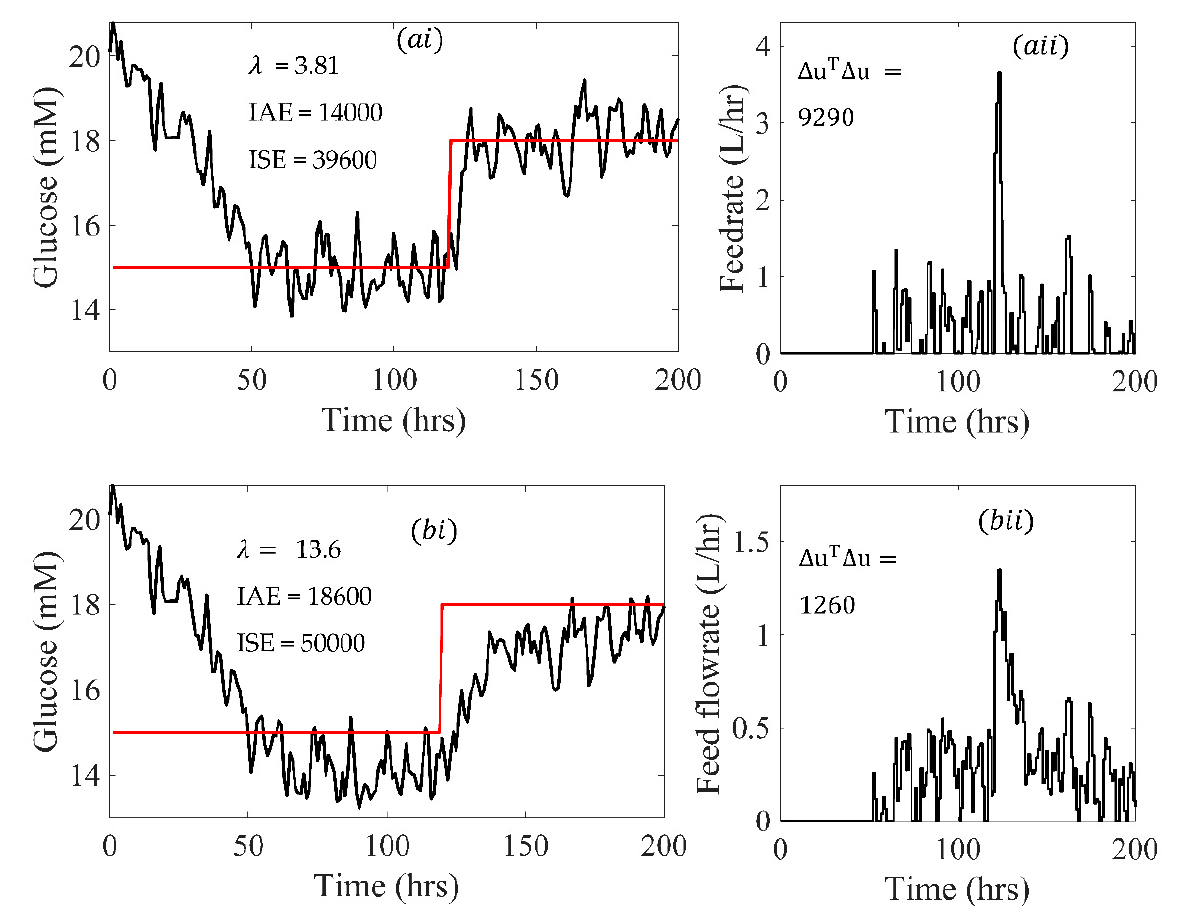
Figure 12. The effect of 𝜆 on the PI controller performance: ( top row ), λ = 3.81; ( bottom row ), λ = 13.6; ( left column ): controlled variable (black) and setpoint (red); ( right column ): manipulated variable.